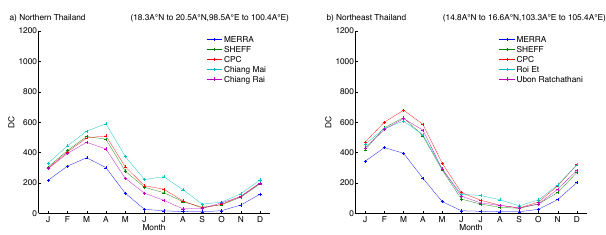
Figure 6. Monthly mean DC for two regions in Thailand. MERRA, SHEFF and CPC DC are from the GFWED gridded fields over the latitude and longitude range specified in the caption. The other two DC plots are for representative weather stations in that